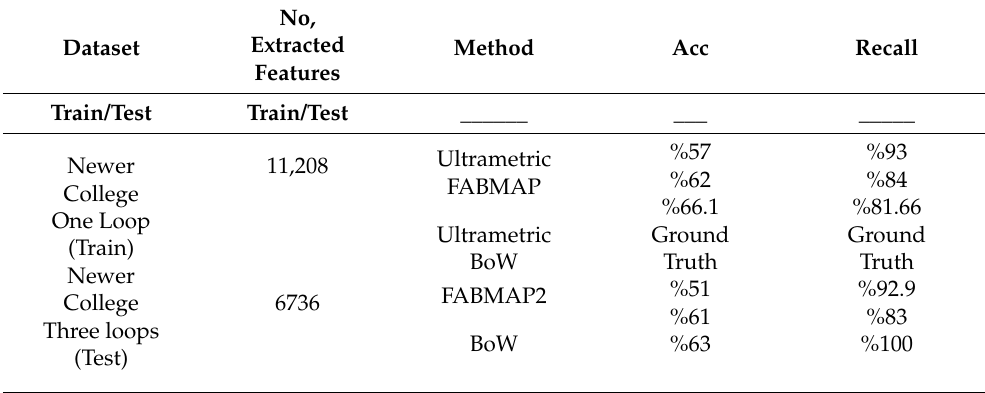
Table 7. Comparison of FABMAP2, Ultrametric-FABMAP and BOW considering Ultrametric-BoW as our ground truth (Training and testing data are swapped according to Table